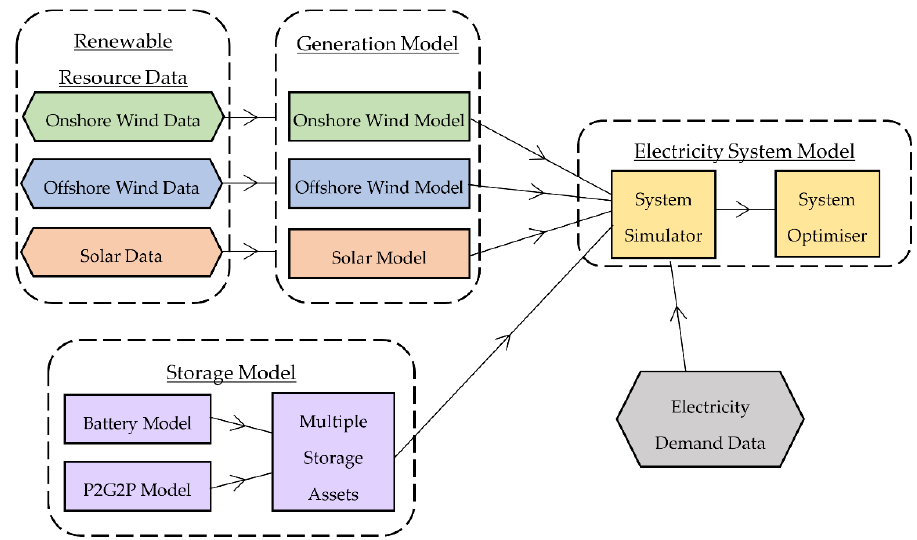
Figure 1. Schematic representation of SCORES model. The “Generation Model” makes use of renewable resource data, and contains sub-models representing onshore wind, offshore wind and solar. A separate “Storage Model” has sub-models representing different storage technologies, and a “Multiple Storage Assets” Model” to manage the interactions between these technologies. The “Electricity System Model” makes use of the Generation Model, the Storage Model, and demand data to carry out simulations or optimisations of the overall electricity system.